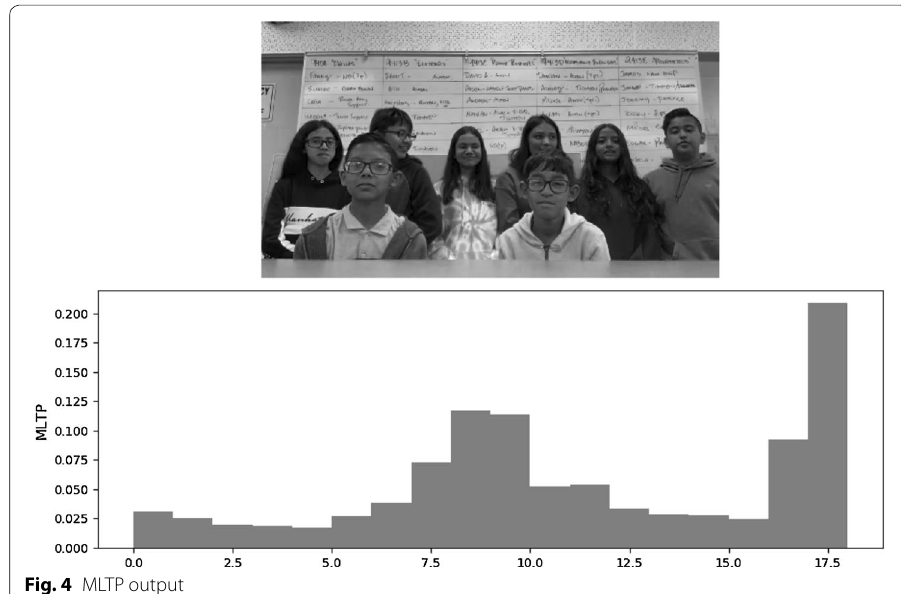
Fig. 4 MLTP output